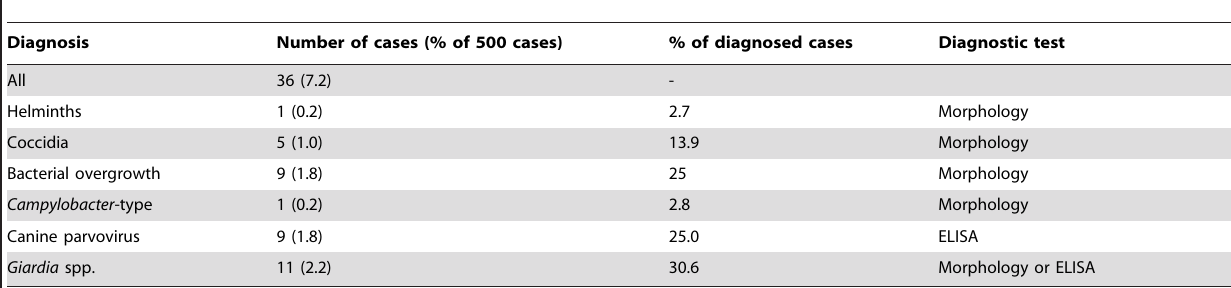
Table 4. Distribution of a sample of companion animal cases with diarrhea by the stated etiological diagnosis (n=500).